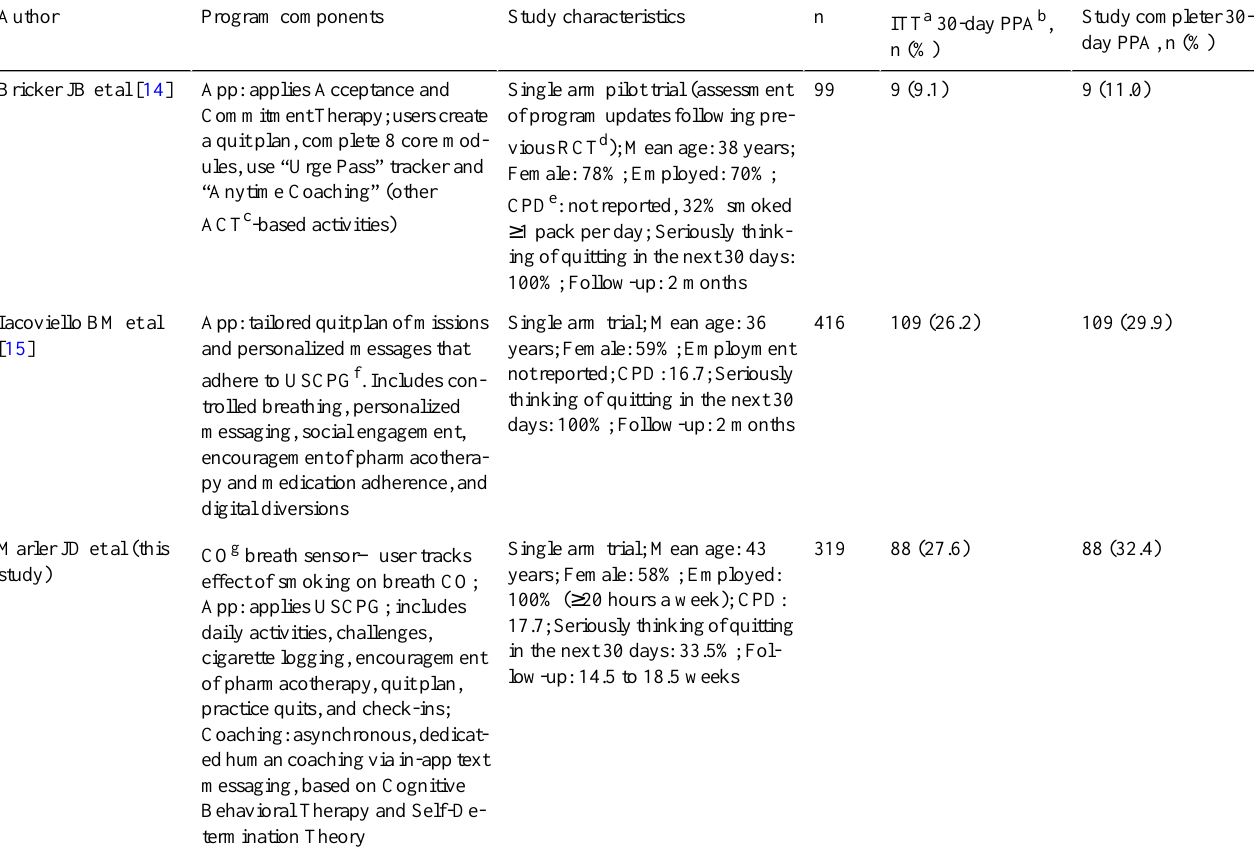
Table 9. 30-day point prevalence abstinence (PPA) in app-based cessation programs.